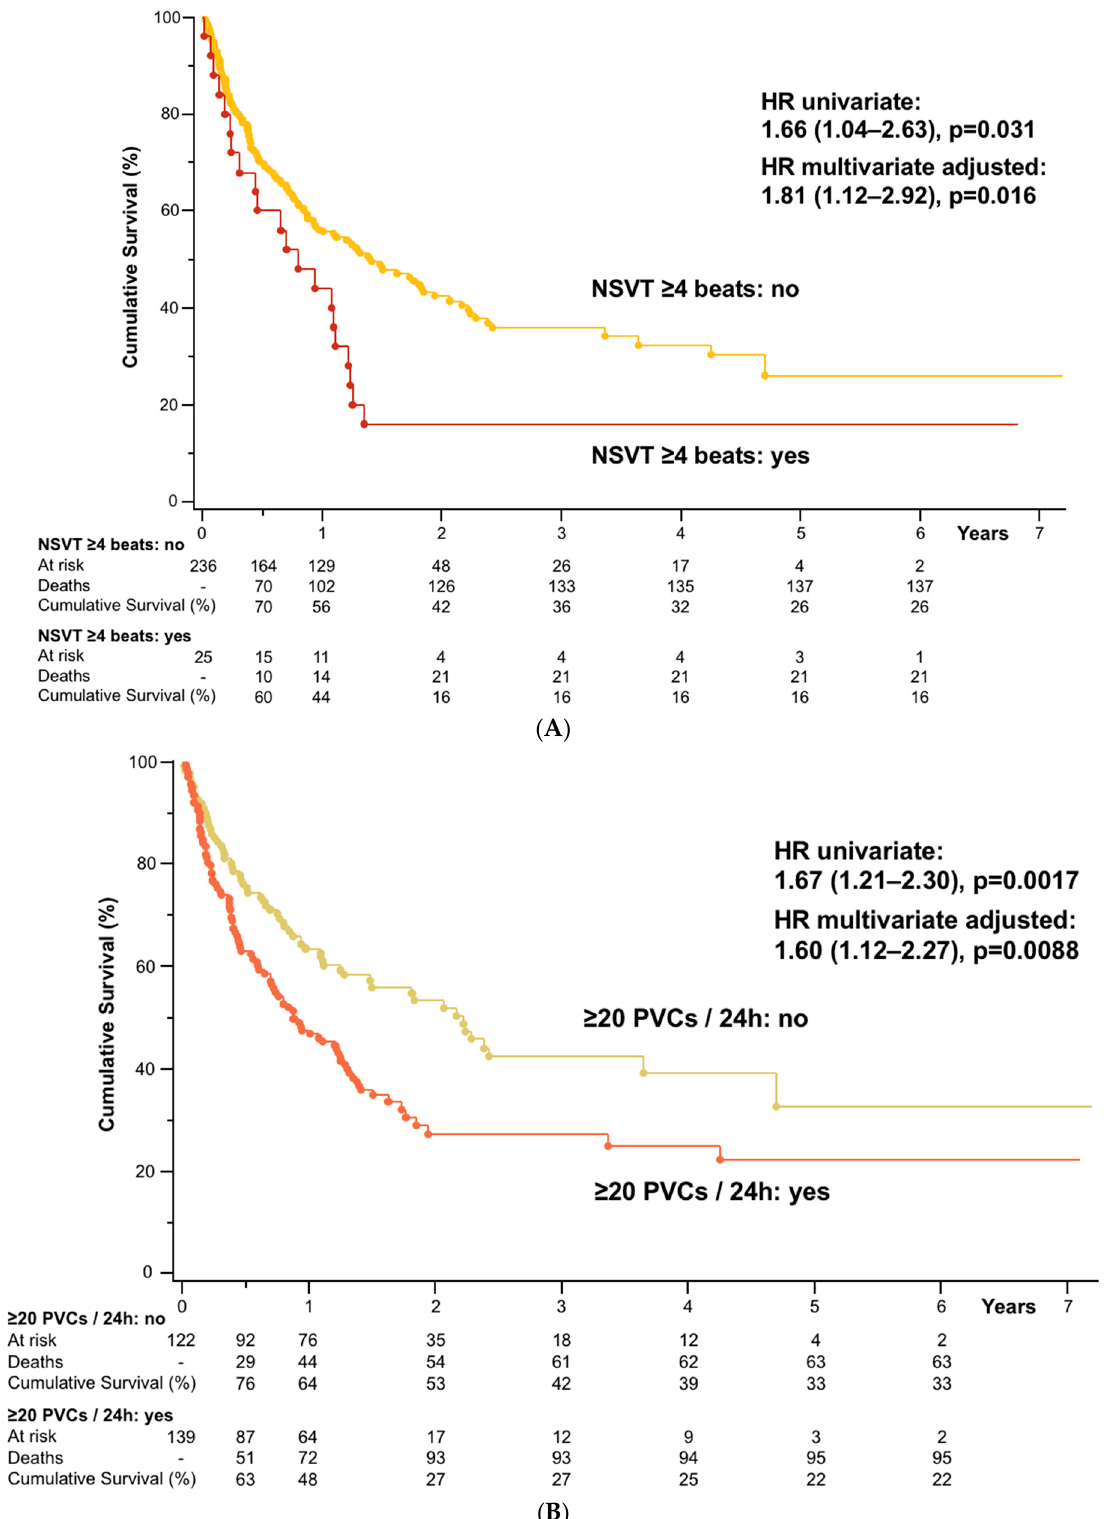
Figure 3. ( A ) Cumulative Survival of all cancer patients ( n = 261 ). NSVT, non-sustained ventricular tachycardia; ( B ) Cumulative Survival of all cancer patients ( n = 261 ). PVCs, premature ventricular contractions.